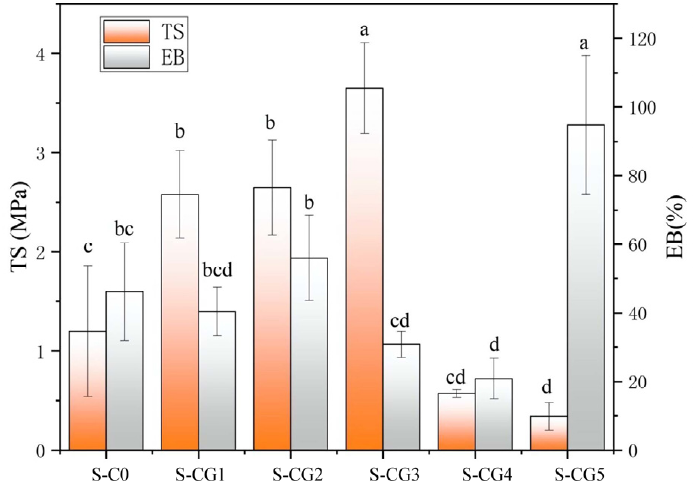
Figure 3. The tensile strength and elongation at break of composite films. Results are expressed as average, and different letters (a–d) indicate significant differences ( p < 0.05).